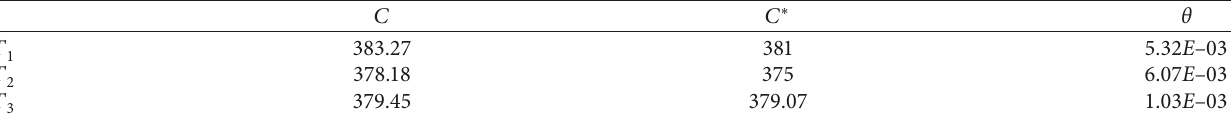
Table 7: Comparison of carbon penalty rates in single period time-varying